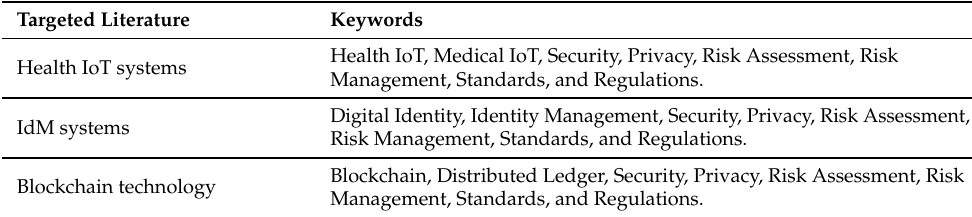
Table 7. The inclusion and exclusion criteria used in the GL. Inclusion Criteria English-written